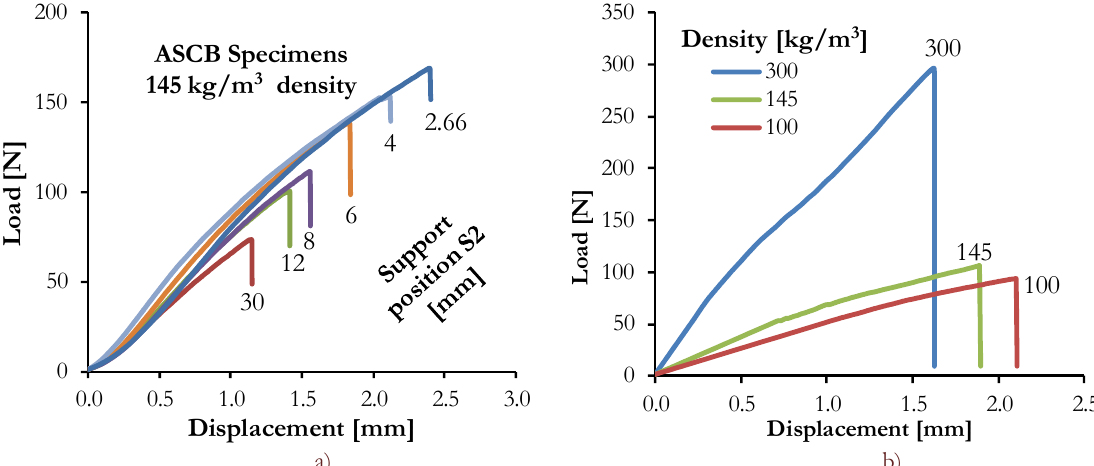
Figure 3: Typical load - displacement curves: a) Influence of applied mixed mode for ASCB specimens; b) Influence of density for SEC specimens loaded in Mode